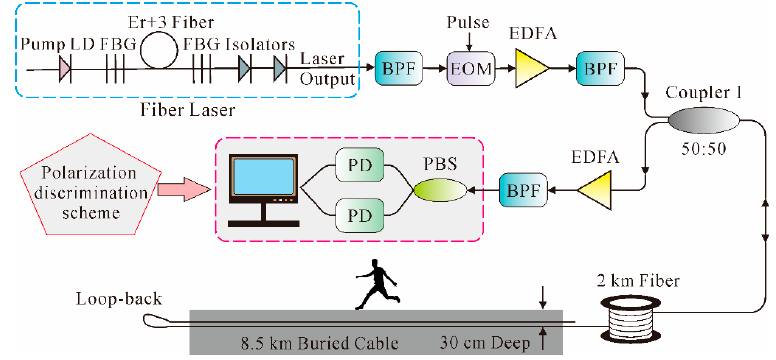
Figure 9. Field tests setup for the Φ -OTDR intrusion detection system, adapted from Juarez et al. [89].